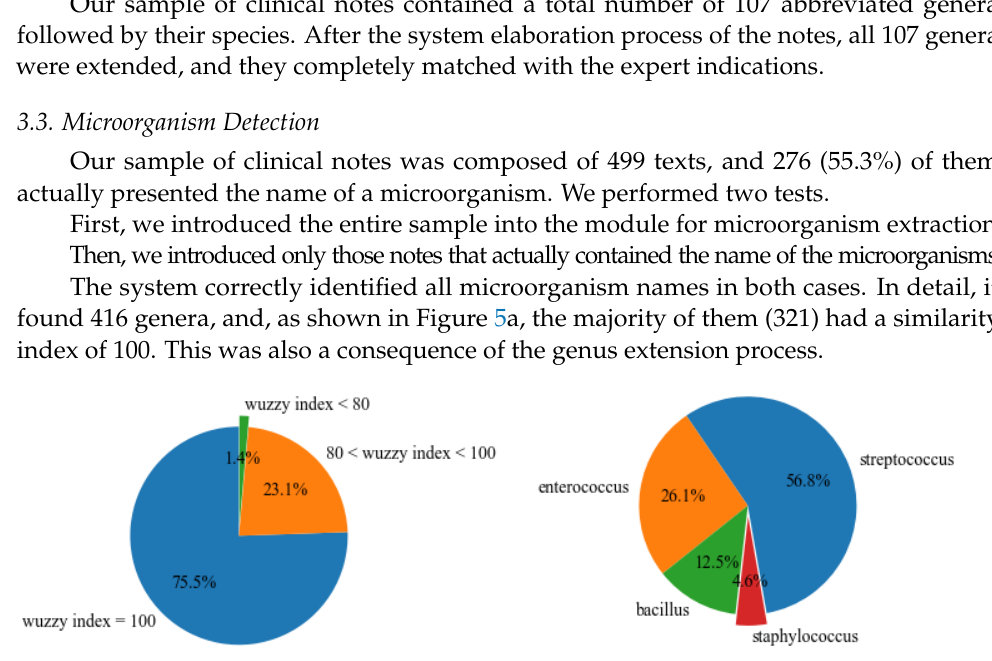
Figure 5. System performance for genus extraction. ( a ) Similarity index percentage distribution of genera. ( b ) Percentage distribution of genera found with low